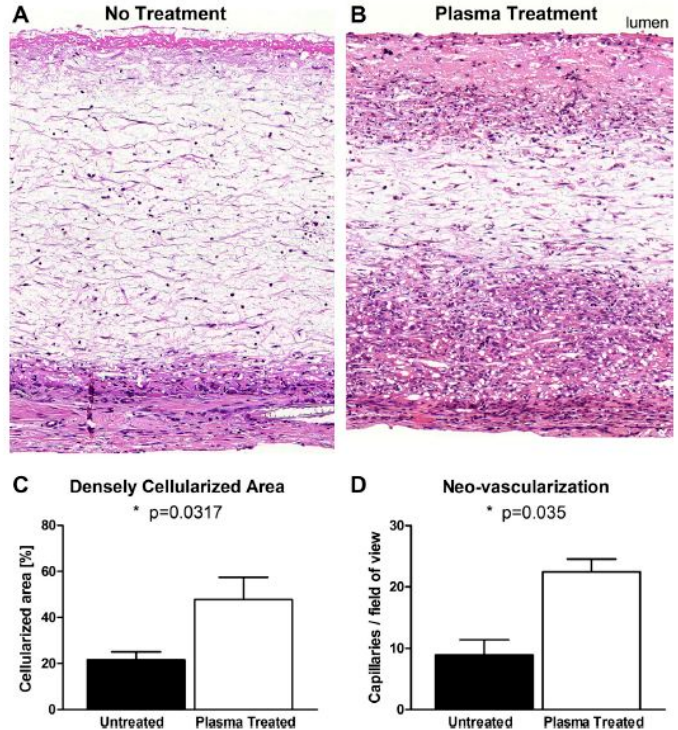
Figure 18. Visualization of the e ff ect of air plasma treatment on tubular PCL sca ff olds after vascular implantation: plasma modification not only promoted the invasion of the cells in the sca ff old wall ( A , B ), but also enhanced the densely cellularized area ( C ) and the number of capillaries in the sca ff old wall ( D )—reproduced with permission from [250]. Copyright Elsevier,